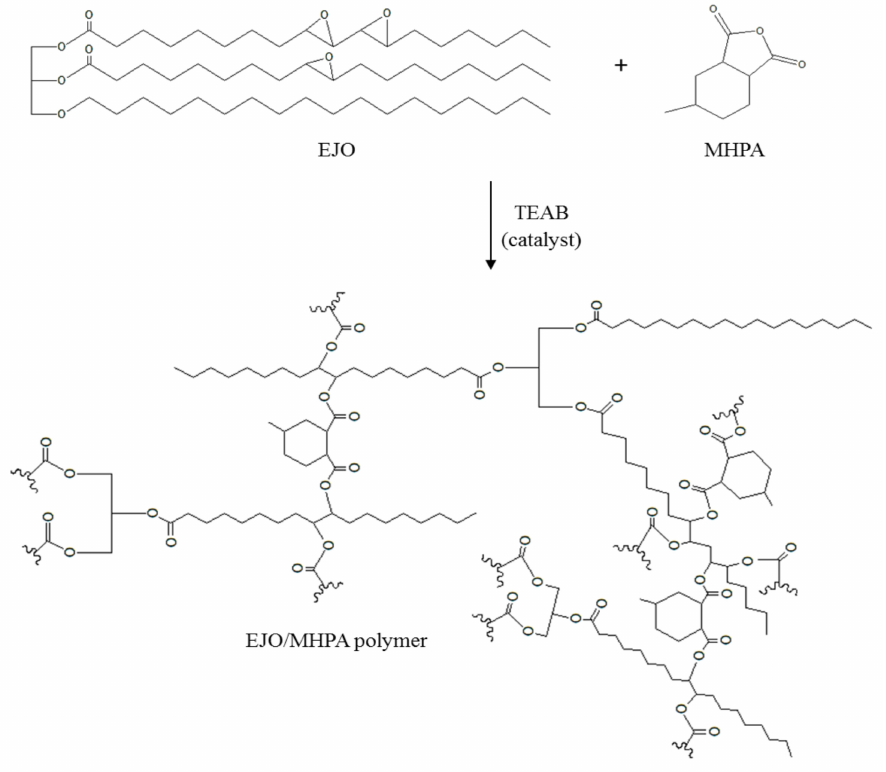
Figure 4. Schematic reaction of EJO and